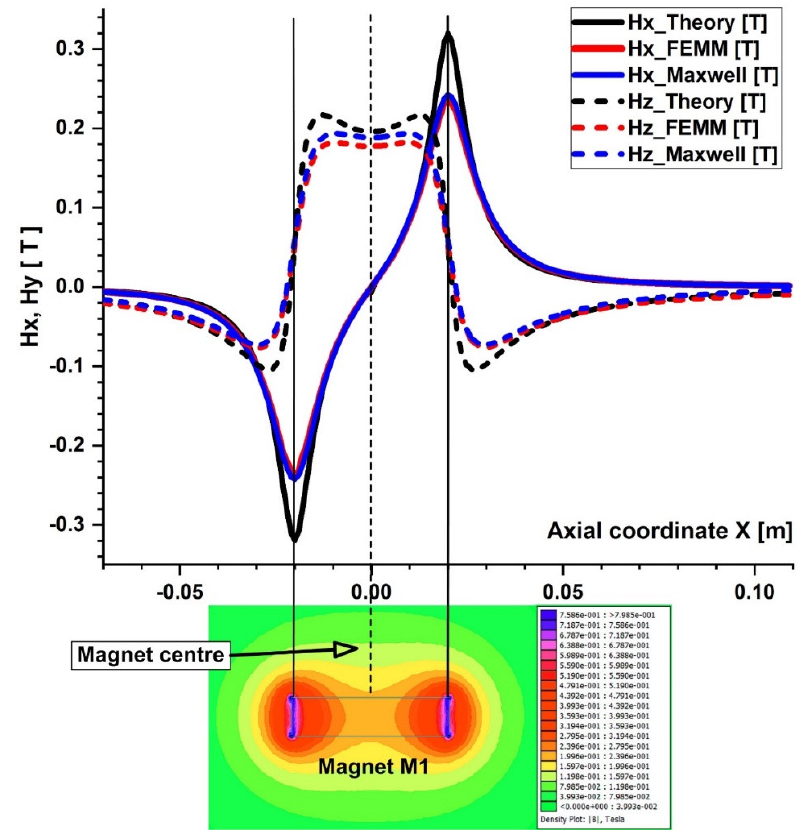
Figure 9. Comparison of the magnetic field components H x and H y obtained analytically, experimen- tally, and using FEA (FEMM and Maxwell software) along the x direction of the bottom wall of the vessel. B-field magnitude distribution for neodymium permanent magnet M1 grade N52 bottom. The distance between the vessel’s bottom wall and the magnet surface is h = 5 mm.